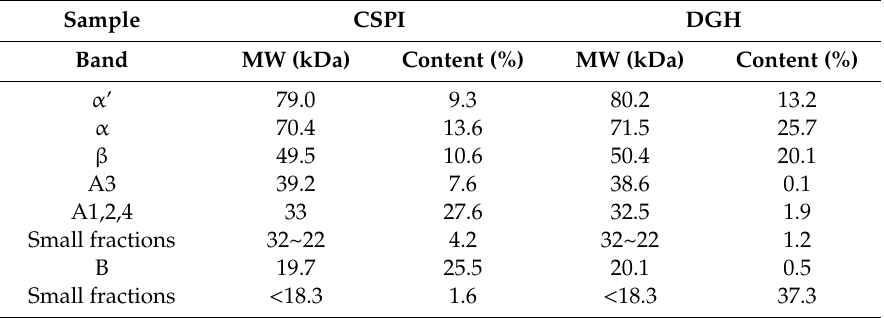
Figure 1. SDS-PAGE patterns of control soy protein isolate (SPI) (CSPI, blank group) and degraded glycinin hydrolysate (DGH, contrast group). Table 1. The relative contents of the individual subunits and small protein fractions in CSPI and DGH according to the densitometric analysis of SDS-PAGE.